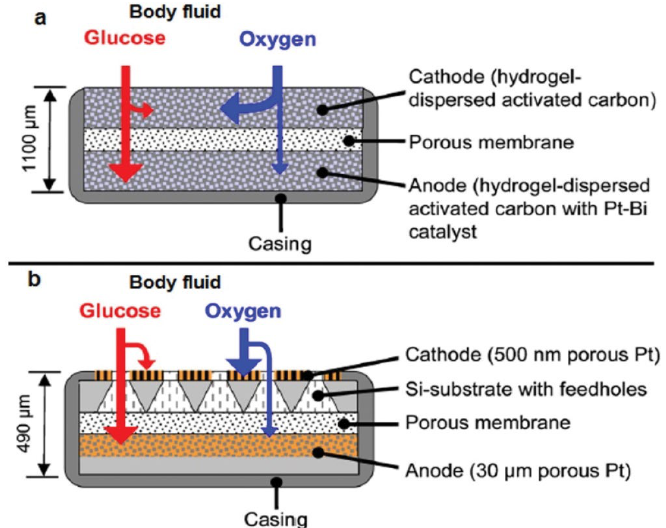
Fig. 3. (a) State-of-the-art approach for abiotic glucose fuel cells with hydrogel-dispersed activated carbon electrodes [18]. (b) Binder-less electrodes in abiotic glucose fuel cells